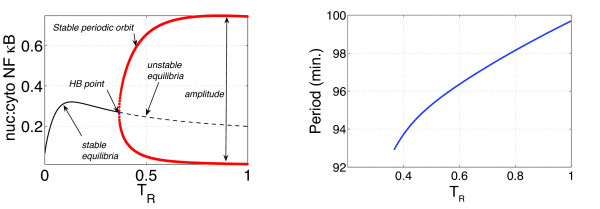
Qualitative behaviour as a function of TR. At left, a bifurcation diagram showing how the oscillatory response depends on TR. The solid black curve in the region 0 ≤ TR ≤ T* represents a branch of stable equilibria-steady, non-oscillating solutions-while the dashed black curve for TR >T* indicates a branch of unstable steady states. The red curves show the limits-the peak and trough values-of the stable oscillatory responses that exists for these values of TR. The panel at right shows period of the oscillation as a function of TR.